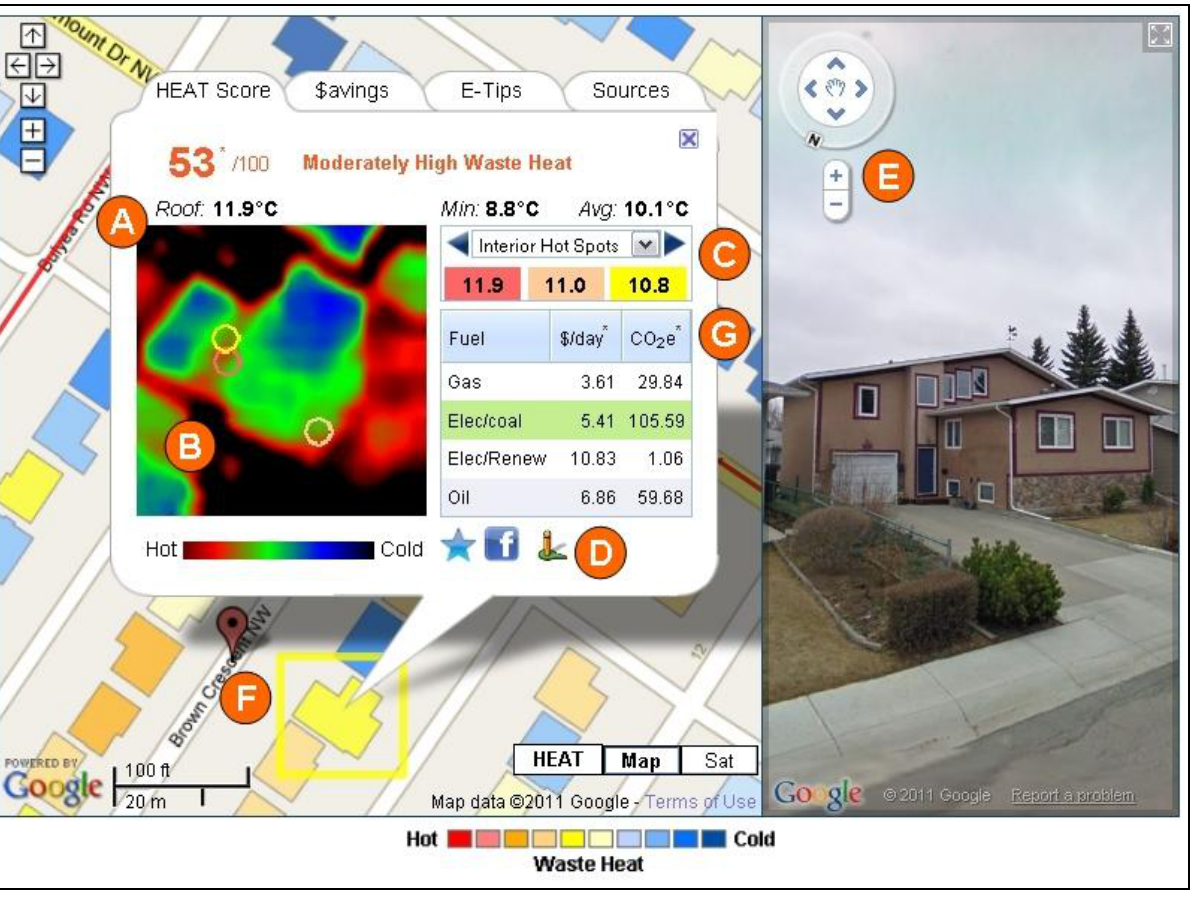
Figure 5. The Home Heat Map provides a thermal image of an individual home showing: (A) the moused-over roof temperature, (B) three Hot Spots and (C) their associated temperatures, (D) the Google Street View icon linked to (E) the corresponding house Street View. (F) shows the map location of the evaluated house. (G) defines the Fuel Table, the associated fuel sources, the heating costs/day ($) and the resulting CO Visual analysis of the Hot Spot locations (B) compared to the Street View image (E) reveal that heat is escaping between the main home structure and the smaller addition (front